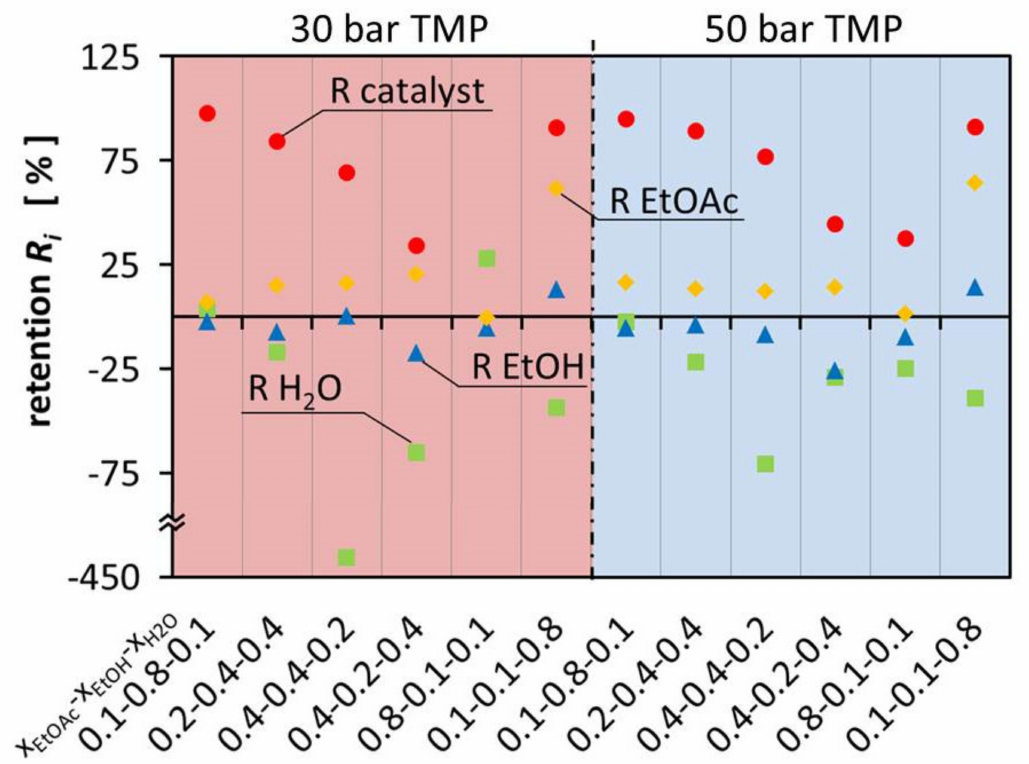
Figure 3. Retention of the components EtOAc, EtOH, H 2 O and the catalyst in aqueous ternary mixture at 30 bar and 50